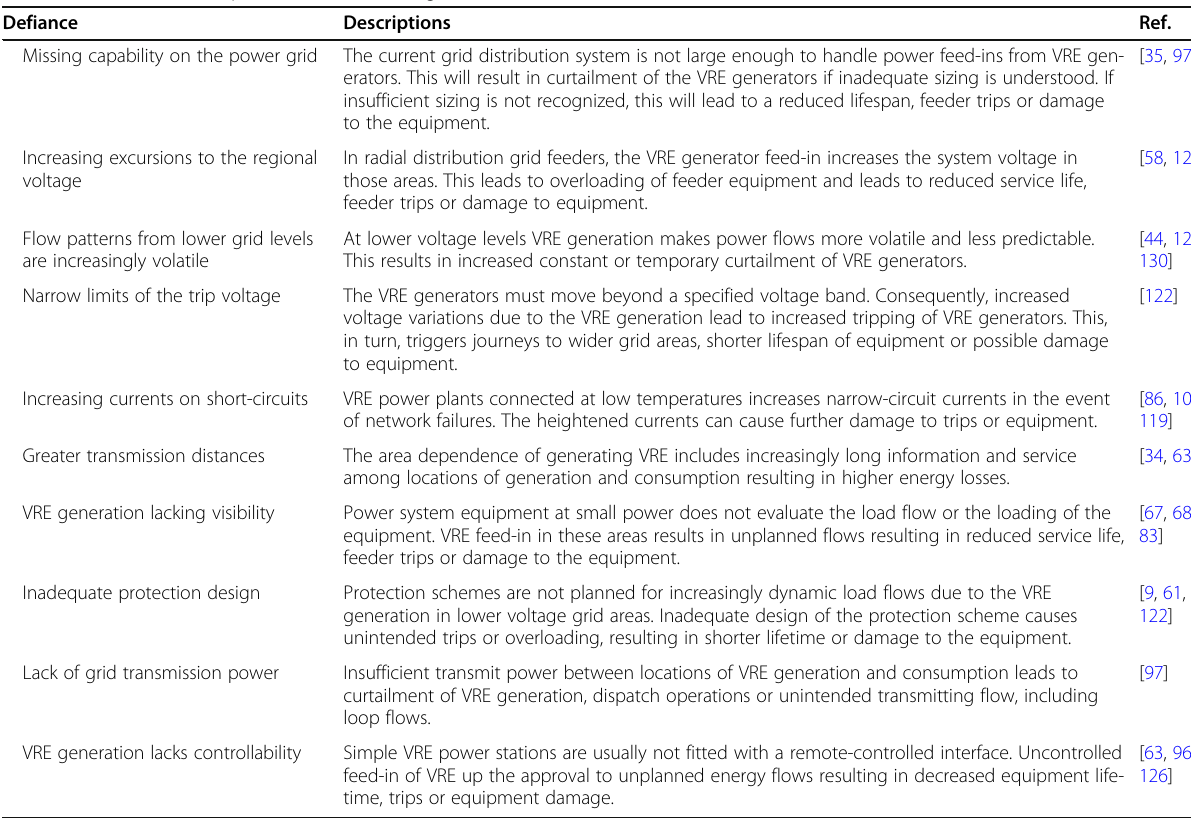
Table 3 Result of VRE Implementation Challenges (Continued)